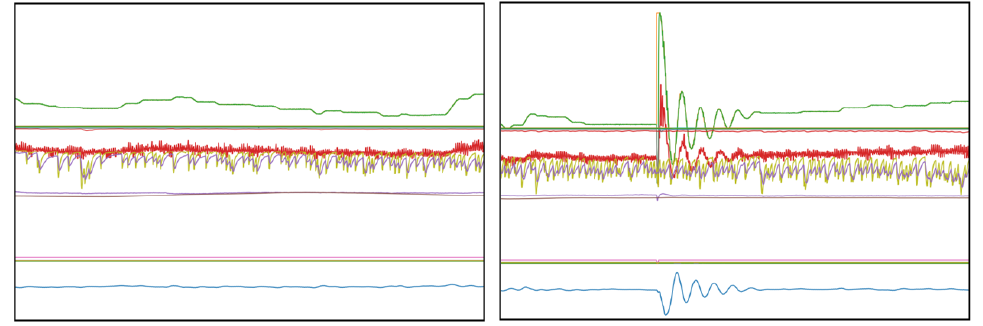
Figure 3. Exemplary representation of steady state (left) and failure event (right).